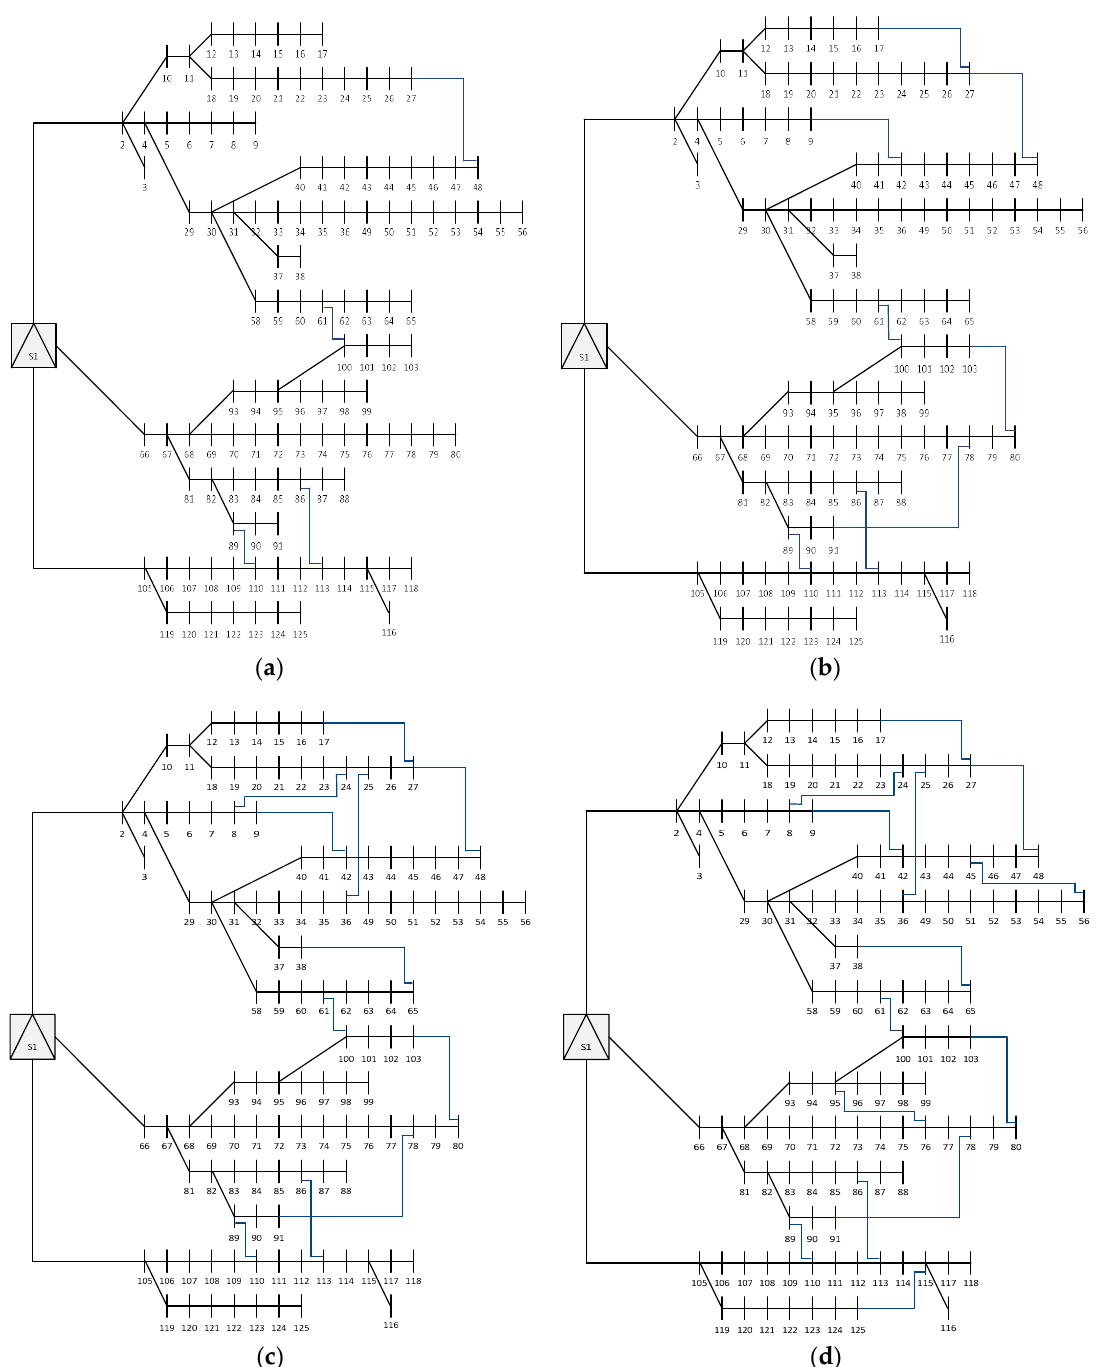
Figure 2. A schematic diagram of the meshed systems associated with Case C to Case F. ( a ) The 30% meshed network topology for Case C; ( b ) the 60% meshed network topology for Case D; ( c ) the 80% meshed network topology for Case E; and ( d ) the 100% meshed network topology for Case F. Table 6. The total expected costs of the objective function and power losses. PNS: Power Not Served.